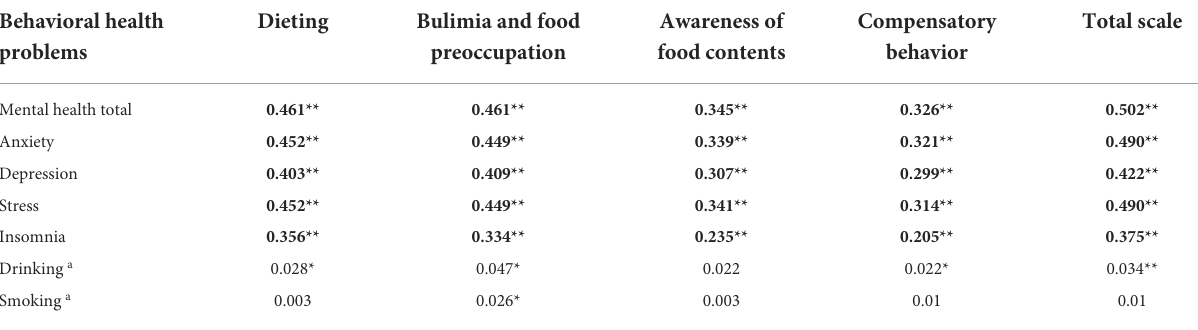
TABLE 7 Associations of behavioral health problems with abnormal eating attitudes.